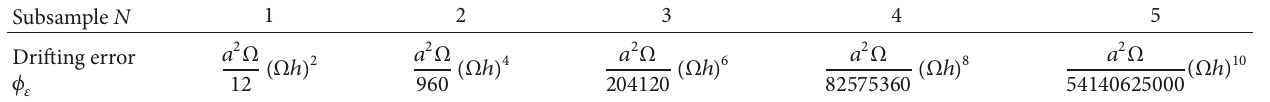
Table 2: Drifting errors for different algorithms of real-time structure.